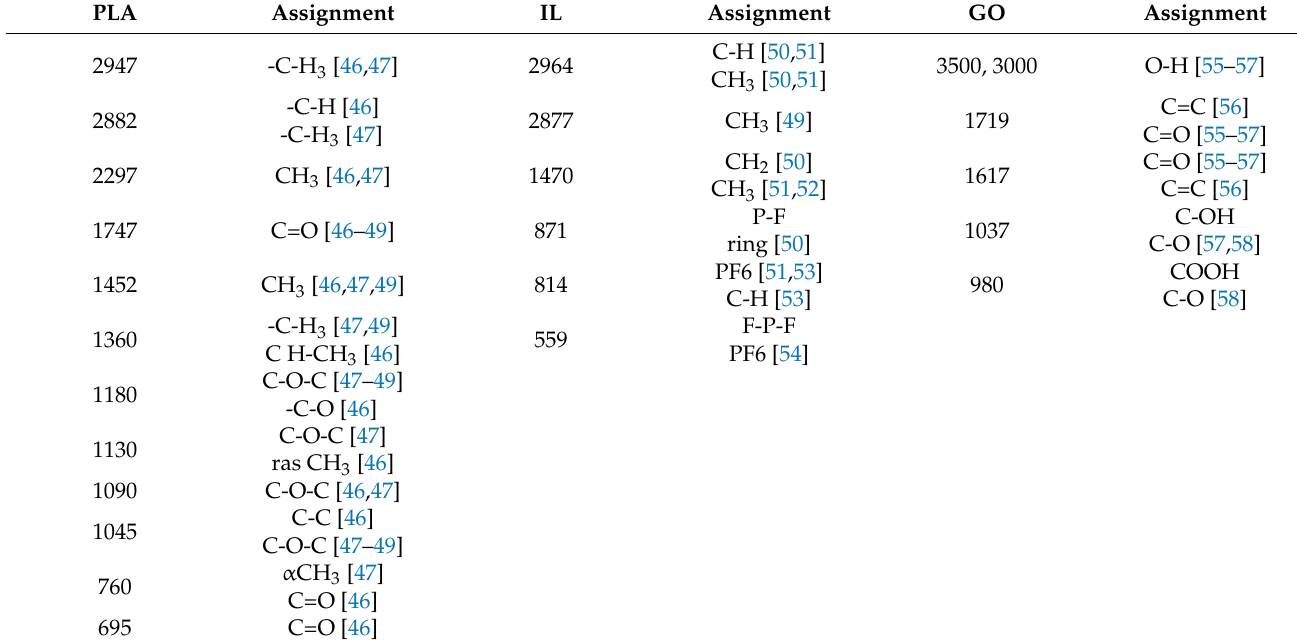
Figure 2. Fourier transform infrared (FT-IR) spectra of PLA, PLP, PGO, and PGL ( a ); [Bmpyr]PF6 ( b ); and graphene oxide ( c ). Table 6. FT-IR frequencies in cm − 1 and